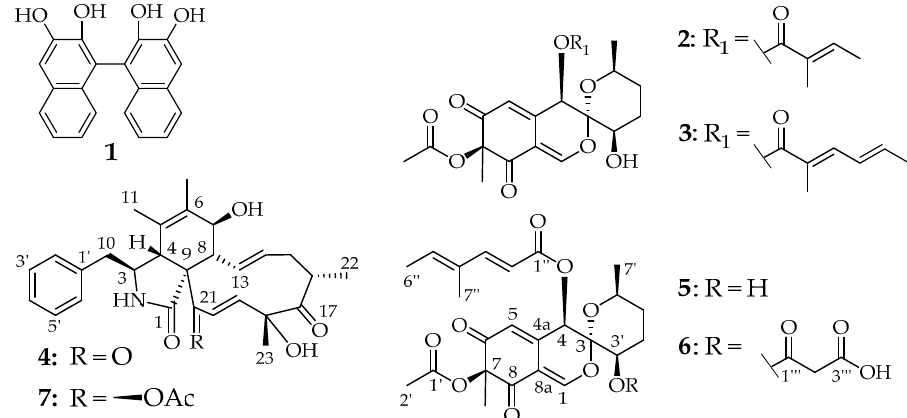
Figure 6. Chemical structures of secondary metabolites of the Hypoxylon fuscum complex: BNT ( 1 ), daldinin C ( 2 ), daldinin E ( 3 ), pseudofuscochalasin A ( 4 ), daldinin F ( 5 ), 3 (cid:48) -malonyl-daldinin F ( 6 ) and cytochalasin C ( 7